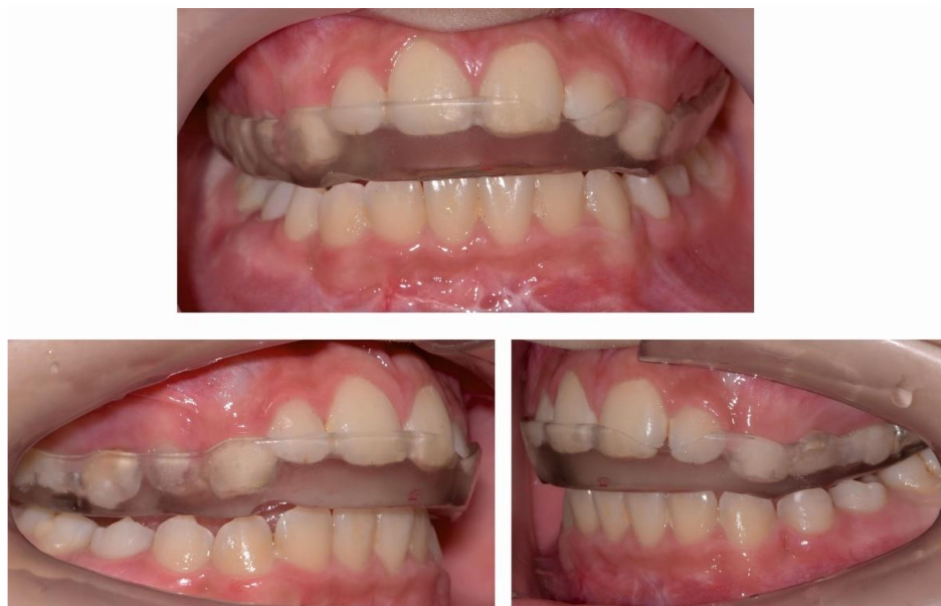
Figure 10. Maxillary one-piece acrylic splint.